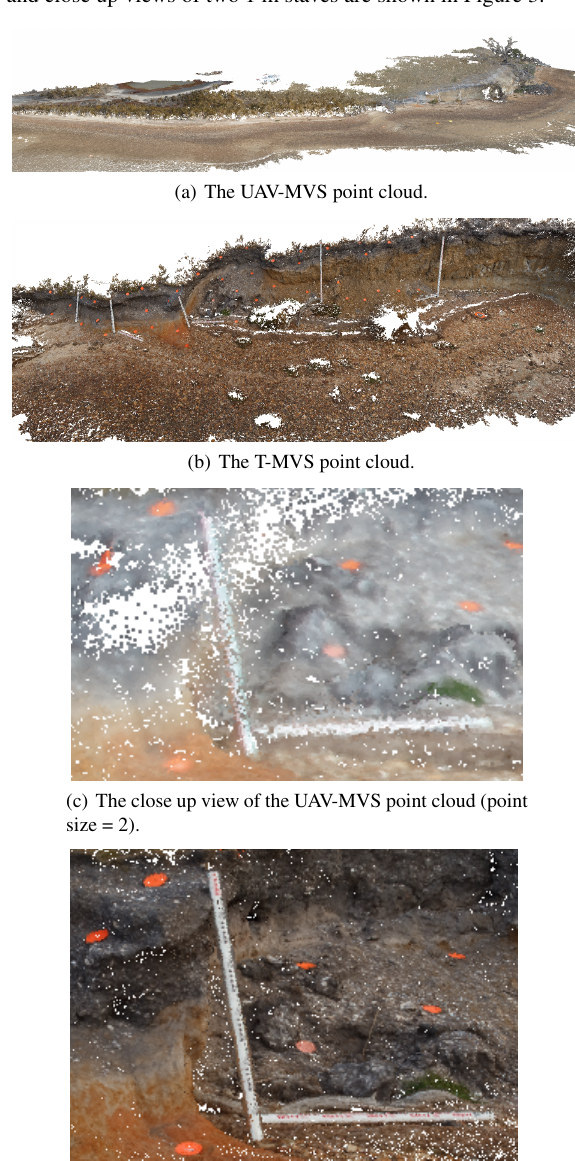
Figure 5: The derived point clouds.